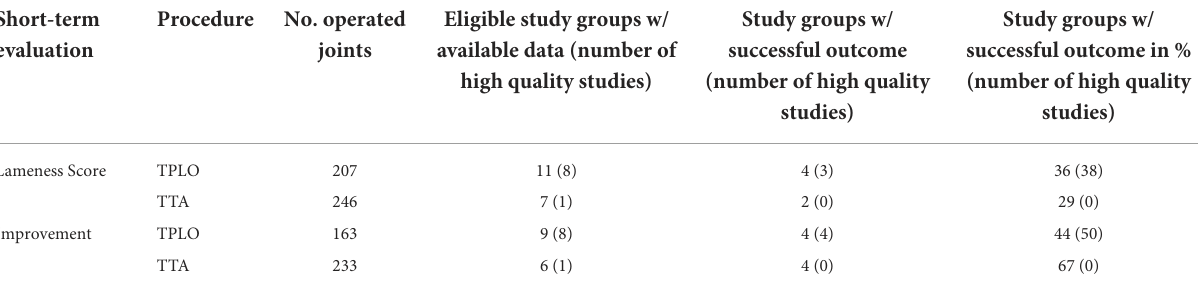
TABLE 3 Subjective lameness at short-term evaluation.